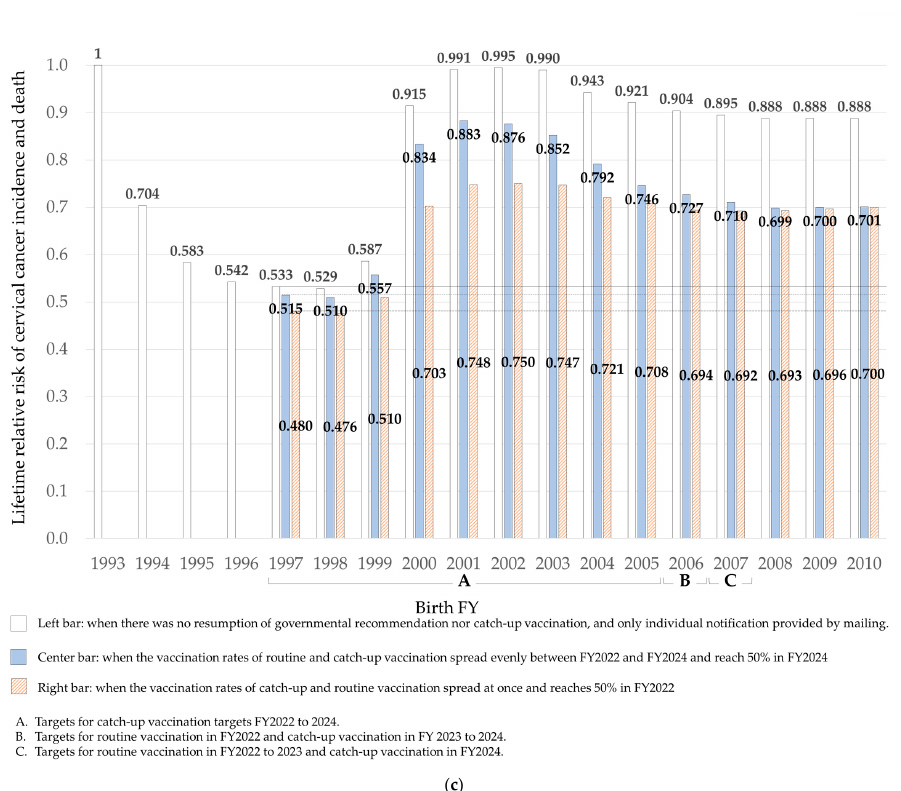
Figure 2. Lifetime relative risk of cervical cancer incidence and death. Vaccination status by birth FY. ( a ) Lifetime relative risk of cervial cancer incidence and death: In a scenaria where the rates of routinne and catch-up vaccinations spread evevly between FY2022 and FY2024. ( b ) Lifetime relative risk of cervial cancer incidence and death: In a scenaria where the rates of catch-up and routine vaccinations. ( c ) Comparison of lifetime relative risk of incidence and death when the vaccination rate reachees 50% in FY2022 and FY2024. In Japan, women born in FY1997 had the highest HPV vaccination rate ever recorded (~70%), whereas females born four years earlier, in FY1993, passed through their vaccine eligible years before the establishment of public subsidies. When the relative lifetime risks of the two groups were compared, the FY1997 women had a risk of 0.533 relative to the risk of 1.000 defined for the FY1993 women (Figure 2a). On the other hand, the risk for females born in FY2000-2003 was 0.915 to 0.991; these women had exceeded the age for routine vaccination without ever being sent an individual notification (Figure 2a). The risks for females born from FY 2004 to FY 2010, who received individualized vaccine information, were 0.943 to 0.888 (Figure 2a).